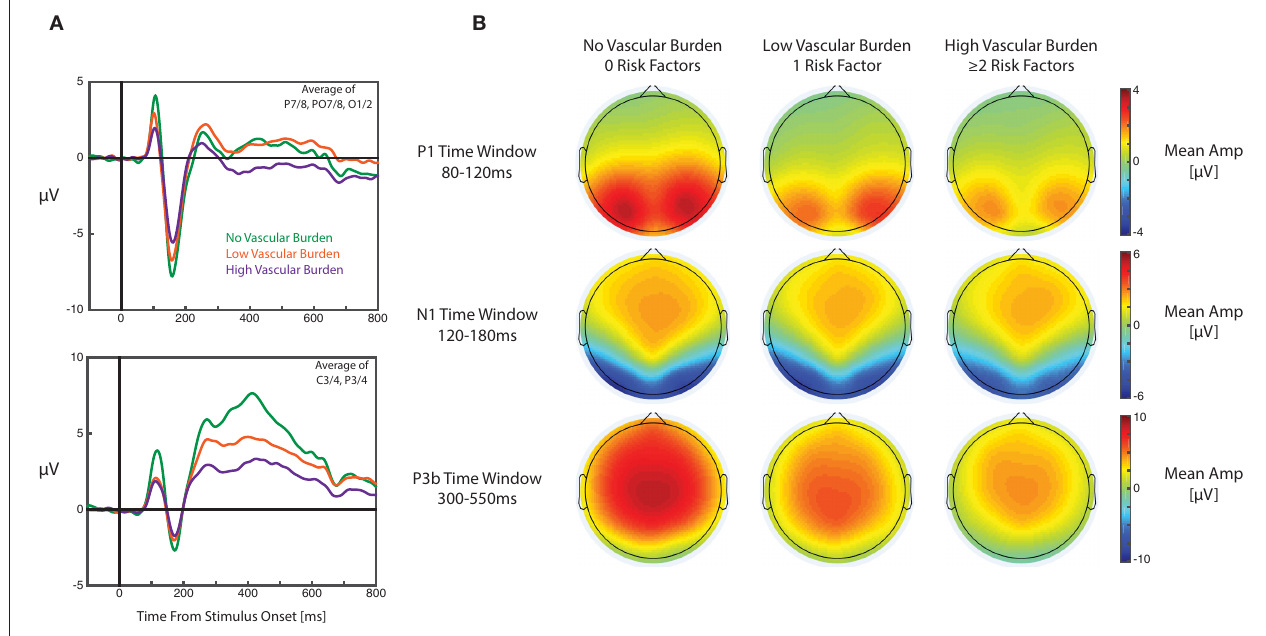
FIGURE 1 | Grand average ERPs and topographic plots for each cardiometabolic burden group. (A) Grand average ERP waveforms for each group averaged over electrodes P7/8, PO7/8, and O1/2 (top panel) and averaged over C3/4 and P3/4 (bottom panel). ERPs were also averaged across versions of the n-back task in these plots. (B) Topographic maps displaying mean amplitudes for each group during the measurement windows for the visual P1 (top row), visual N1 (middle row), and P3b (bottom row).